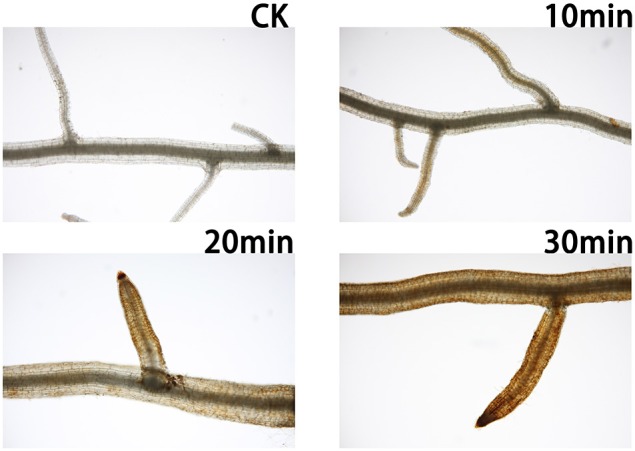
Sample roots were treated with DAB to detect H2O2 in the dark for 4 h. CK, Plants grown under normal conditions produced little H2O2; 10 min, in plants treated with salt for 10 min, the H2O2 level was slightly increased in lateral roots, while H2O2 was also detected in the main root; 20 min, in plants treated with salt for 20 min, H2O2 accumulation was detected in the entire root; 30 min, in plants treated with salt for 30 min, the roots were submerged in H2O2.